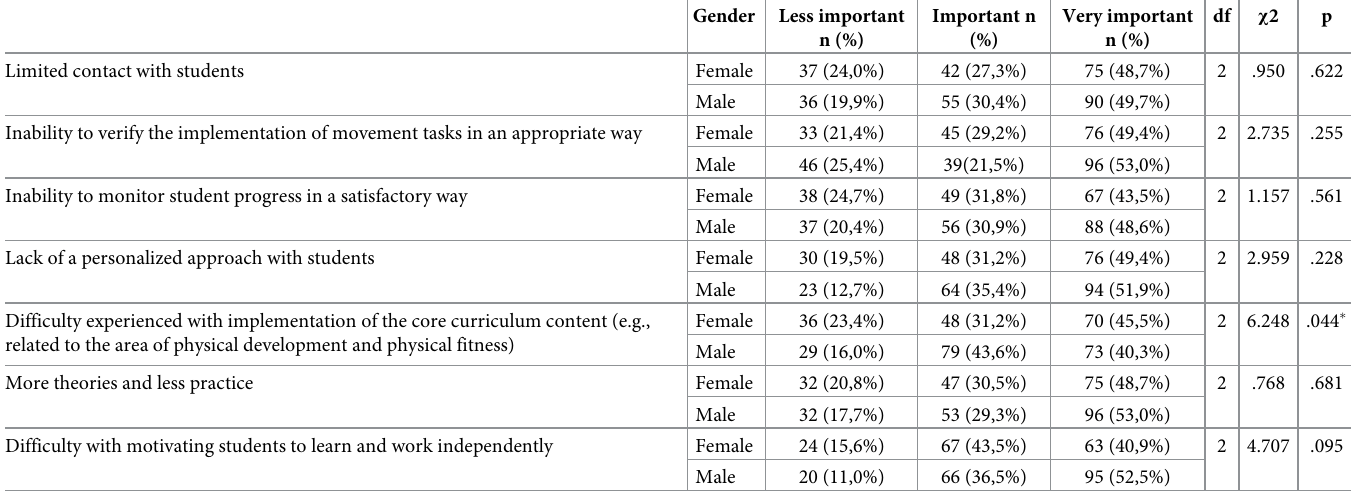
Table 2. Pets’ opinions on the disadvantages of online physical education teaching by